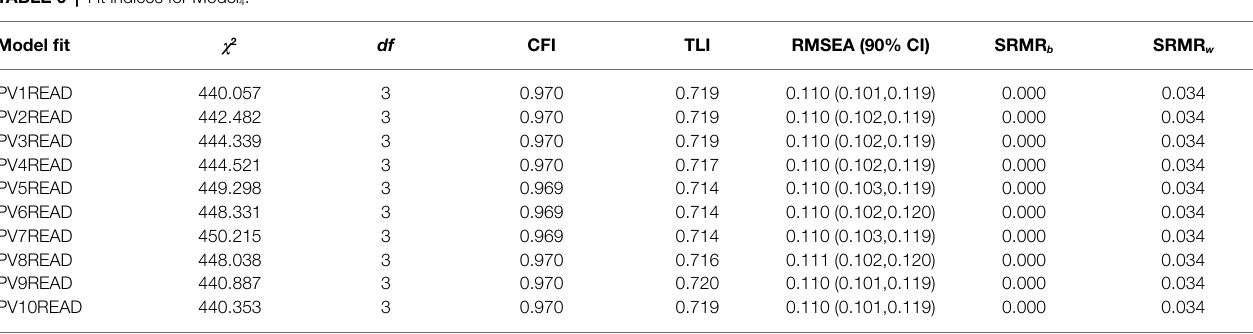
TABLE 6 | Fit indices for Model 4 . Model